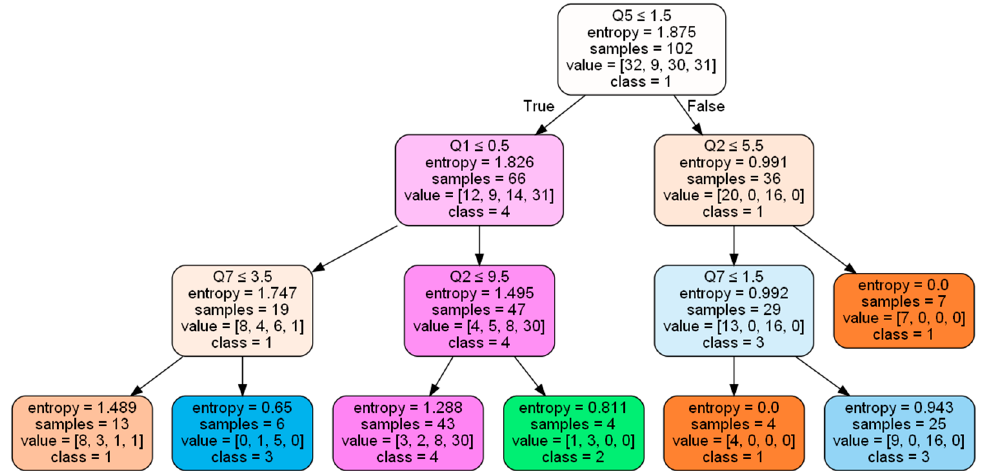
Figure 9. Decision tree of sorting class IDs in Gini criterion (depth = 3).